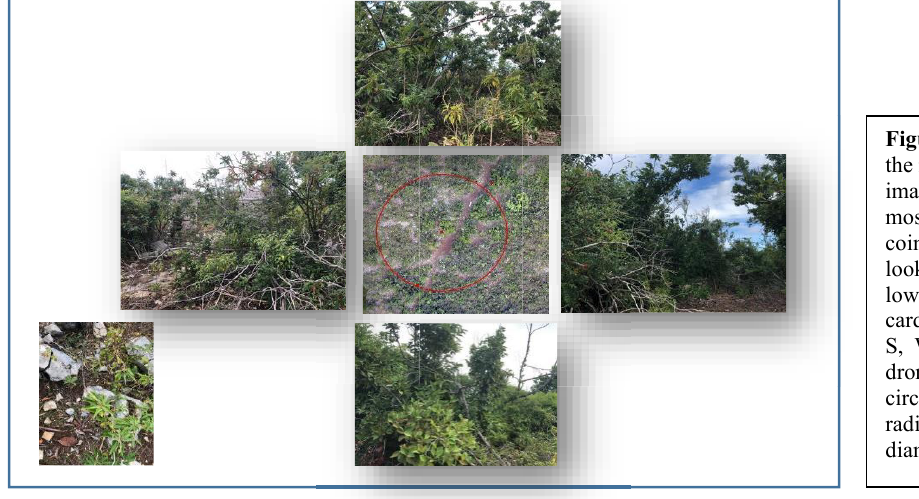
Figure 8: Comparison of the map view of the drone imagery (middle mosaiced photo) and